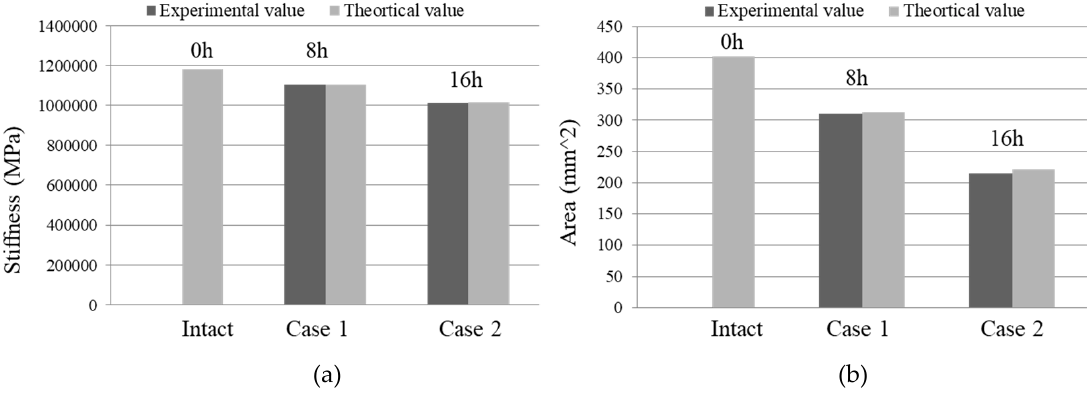
Figure 11. Corrosion quantification for Level 2. ( a ) Identified stiffness; ( b ) Identified steel area.